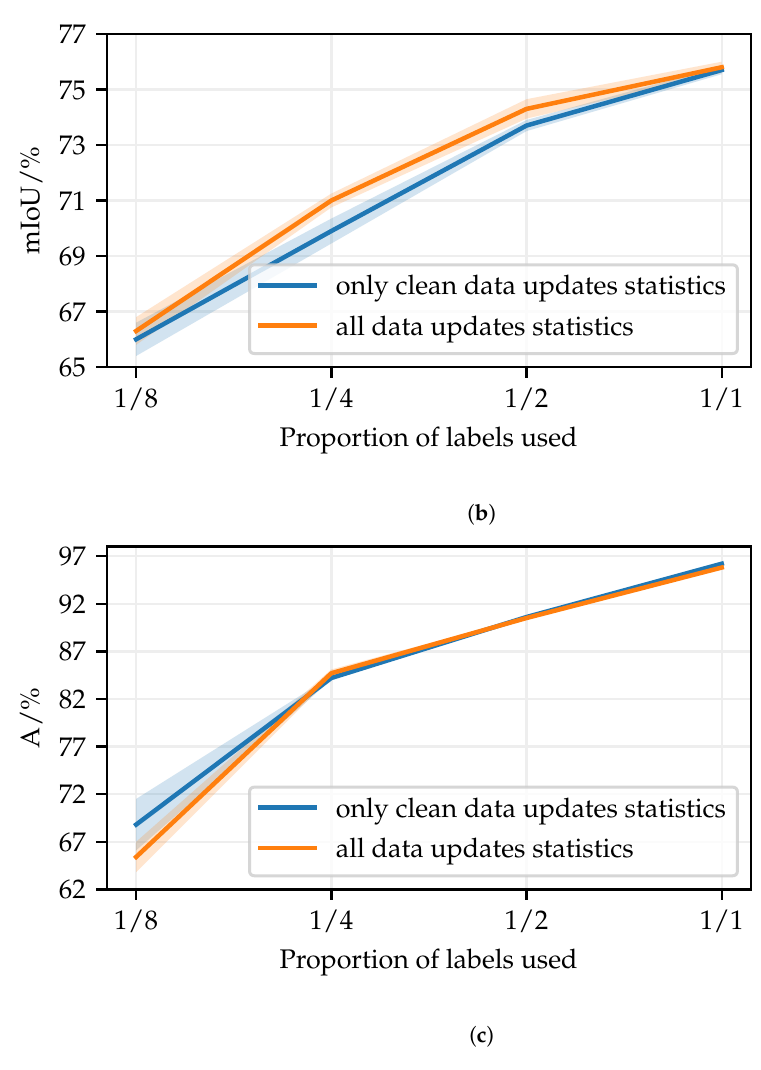
Figure A1. Effect of updating batch normalization statistics in the perturbed student. ( a )